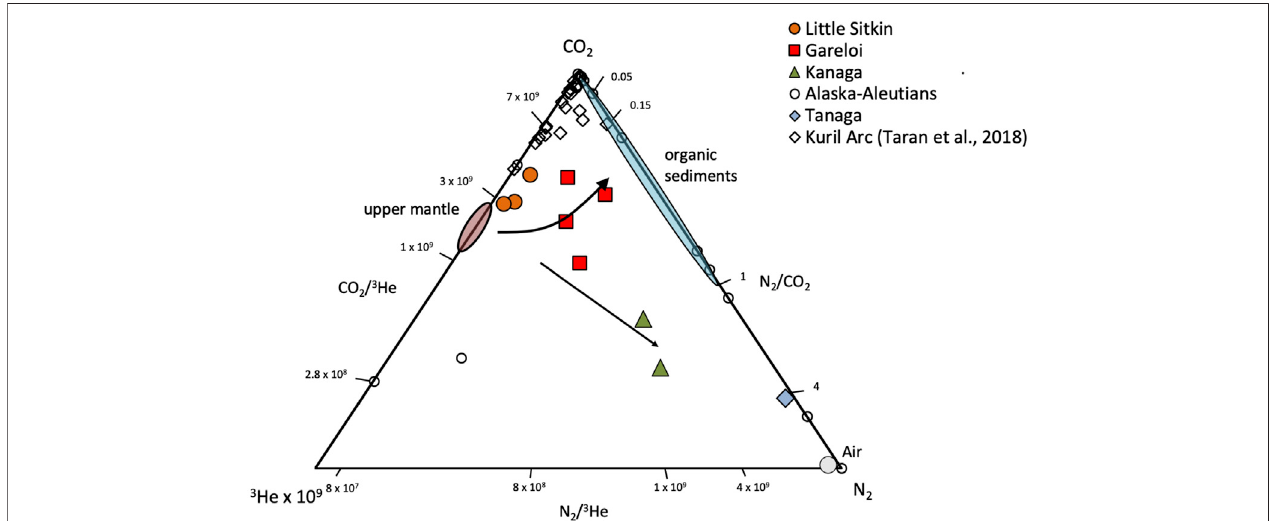
FIGURE9| CO 2 , 3 He, 4 He relative abundances ofgases sampled inthisstudy. Upper mantle gases arecharacterized byCO 2 / 3 He of ∼ 2 × 10 9 and N 2 / 3 He of ∼ 1 × 10 6 Subducted organic sediments have signi fi cantly higher CO 2 / 3 He and N 2 /3He and are dominated by N 2 over CO 2 (Marty and Jambon, 1987; Sano et al., 2001), resultinginmolarN 2 /CO 2 < 1.Subducted carbonates haveCO 2 / 3 He of1 × 10 13 (Sanoand Marty,1995)and theNcontentofAOC isontheorderof2 – 20 ppm(Liet al., 2007)whileCO 2 intheAOC isaround2000 ppm(Alt andTeagle,1999).Assuminga10 ppmwNcontentanda2,000ppmwCO 2 contentoftheAOC wouldresult in a N 2 /CO 2 molar ratio of ∼ 0.02 or less.(Taran et al.,